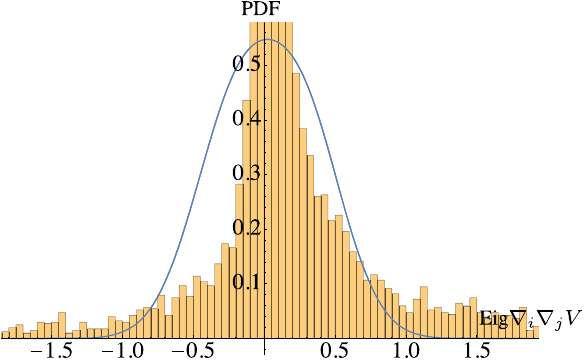
Fig. 11 Density distribution for all the eigenvalues of the mass matrix